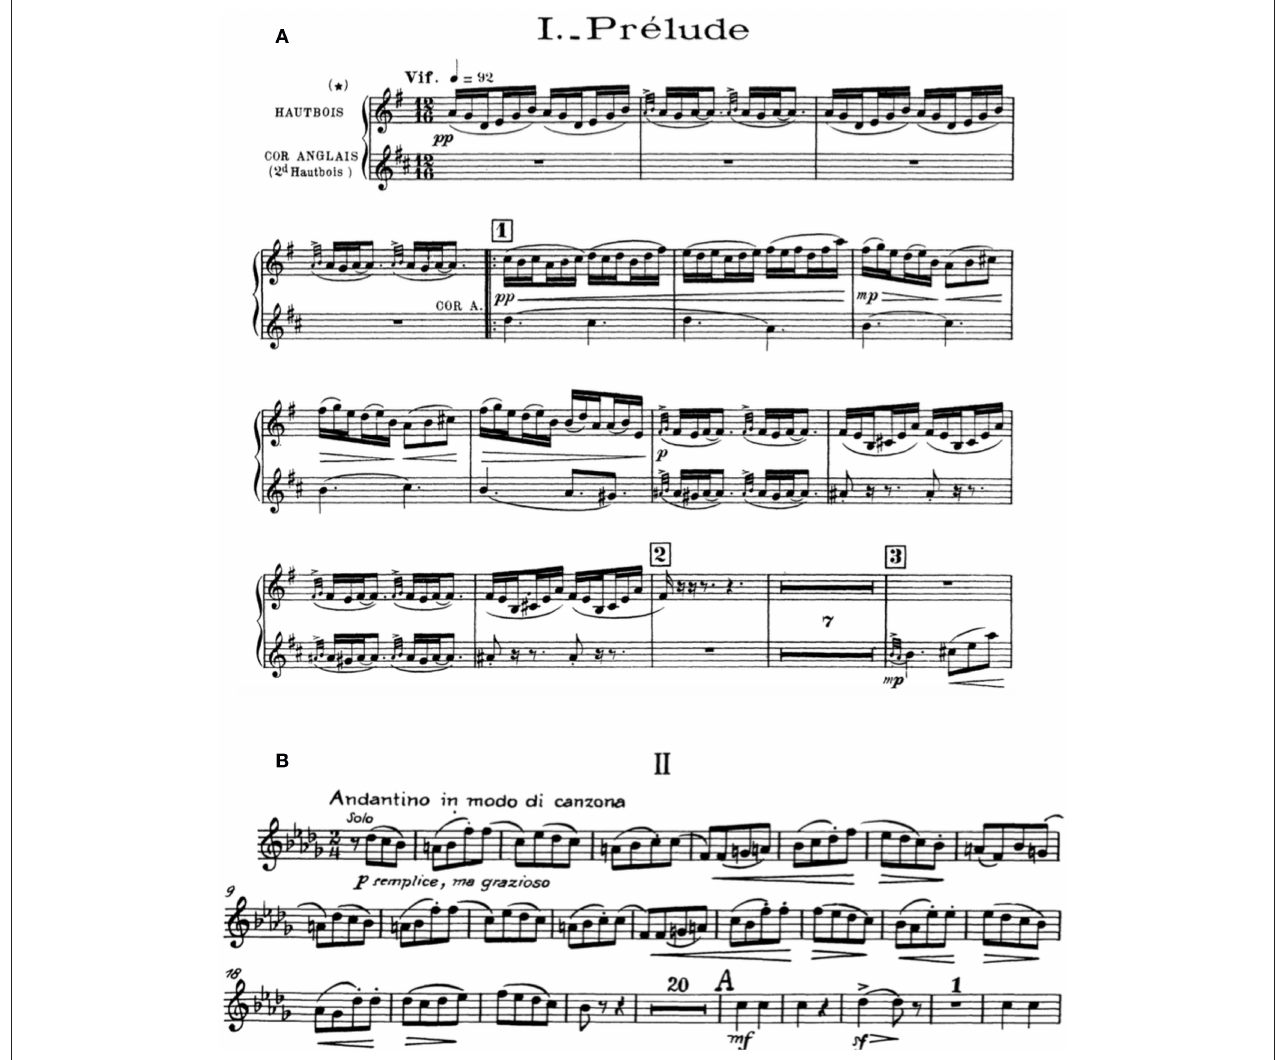
FIGURE 2 | Musical excerpts recorded for the simulation. Top panel (A) oboe solo from the Prélude of Maurice Ravel’s Tombeau de Couperin , bars 1–14 (Ravel, 1919 , p. 1); bottom panel (B) oboe solo from the second movement of Tchaikovsky’s Symphony No. 4, Op. 36 , bars 1–21 (Tchaikovsky, 1946, p. 6).